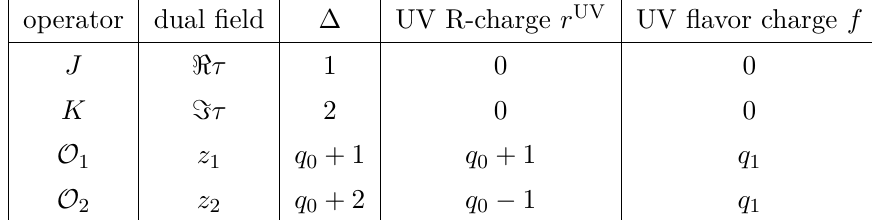
Table 2. UV scaling dimensions and